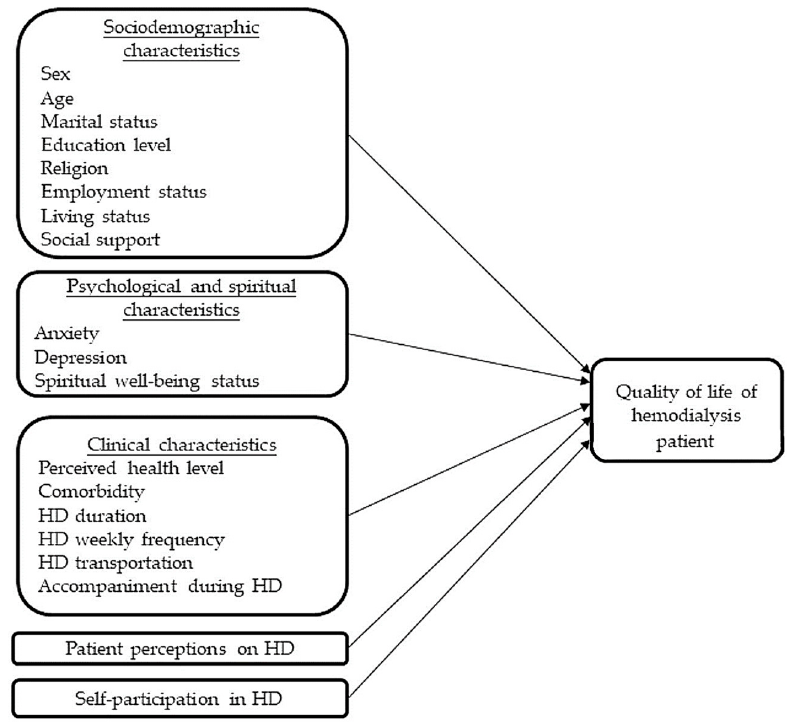
Figure 1. The study